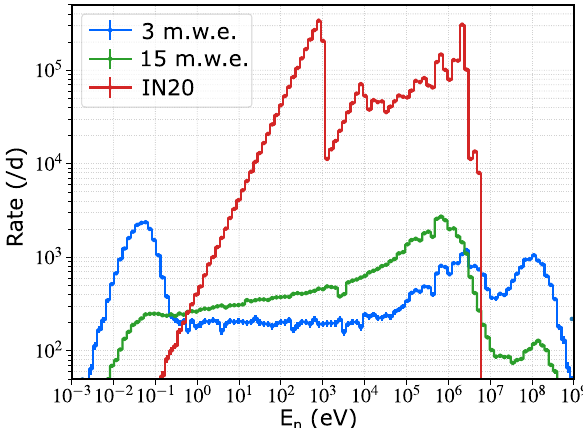
Fig. 5 Simulated neutron fluxes entering the 3 He detector per day as a function of energy for the reactogenic (IN20 – red from [28]), and the cosmogenic neutrons component at the two different locations con- sidered in this work: IP2I surface lab with a ∼ 3 m.w.e. of overburden (blue), and the ILL-H7 reactor site with its mean 15 m.w.e. of over- burden (green). Note that the binning along the x-axis is